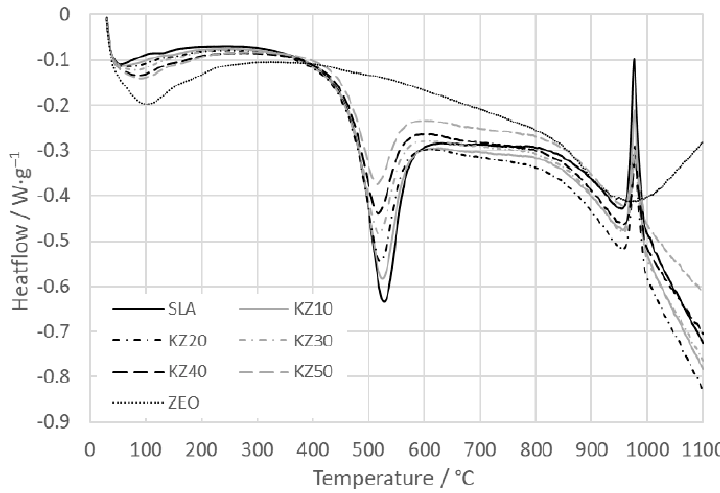
Figure 2. Differential scanning calorimetry (DSC) of the studied samples.